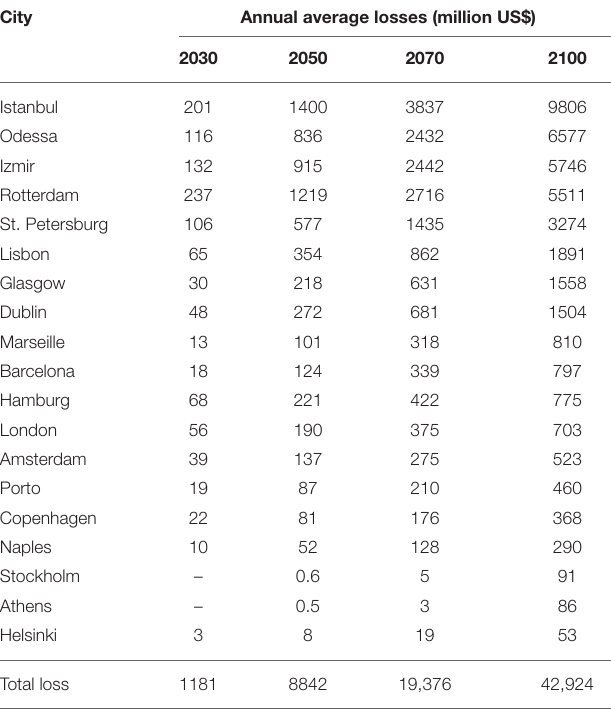
TABLE 4 | European cities ranked by annual average losses (AAL) in 2100. City Annual average losses (million